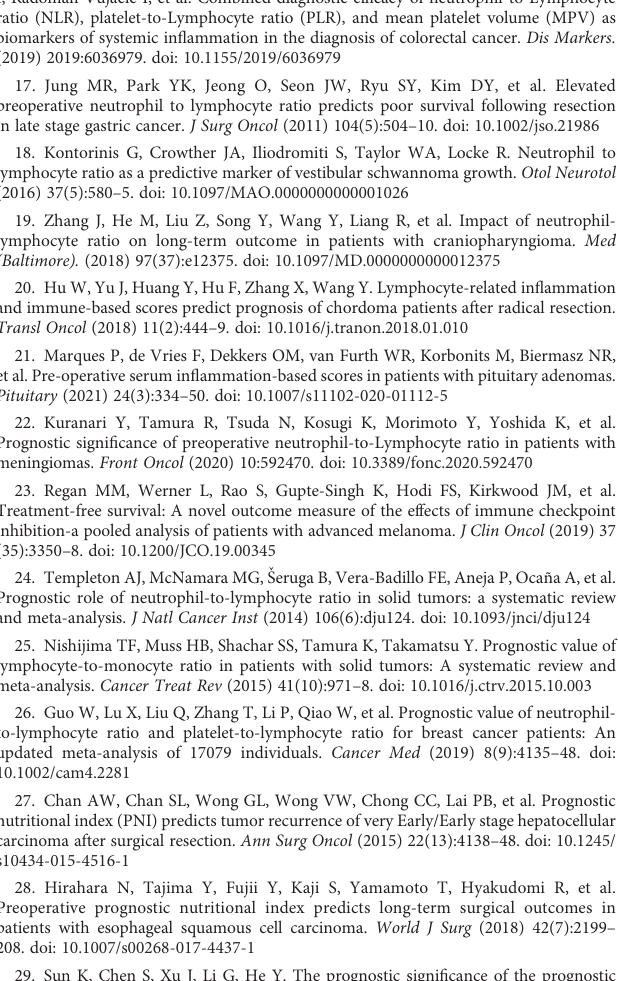
SUPPLEMENTARY FIGURE 1 Receiver operating characteristic curves for recurrence and retreatment SUPPLEMENTARY FIGURE 2 Kaplan – Meier recurrence-free survival curves with patients strati fi ed according to neuro fi bromatosis type 2 status and optimal neutrophil-to-lymphocyte ratio cut-off